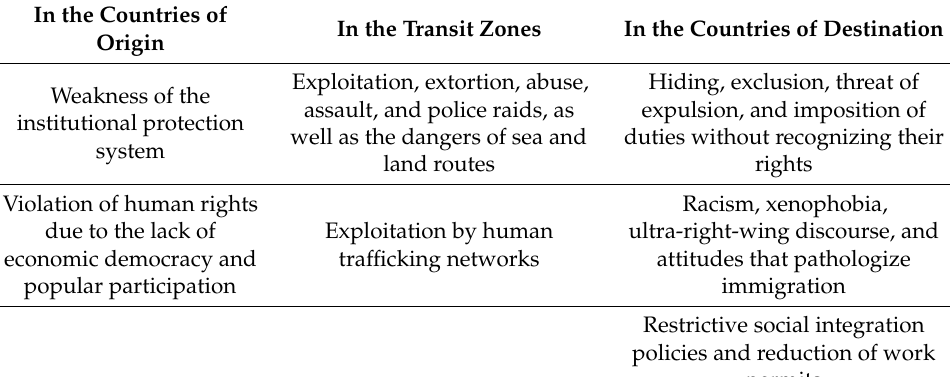
Table 1. Violation of migrants’ human